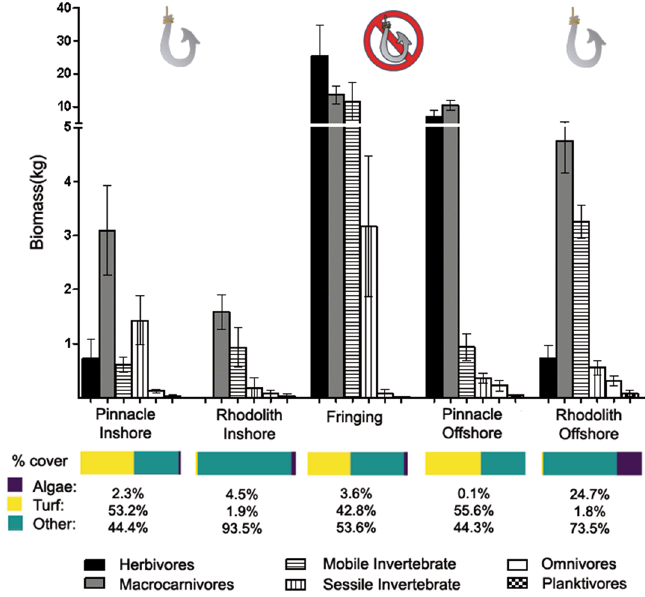
Figure 4. Fish abundance by trophic guild and relative benthic cover in each sampled stratum. Fringing reefs and offshore reef pinnacles are within the no-take enforced zone of the Abrolhos National Marine Park (ANMP). Generated with Freeware R (www.r-proje